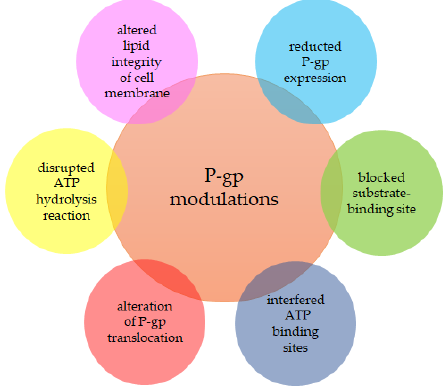
Figure 1. Mechanisms of P-gp modulations [31,34,48 –